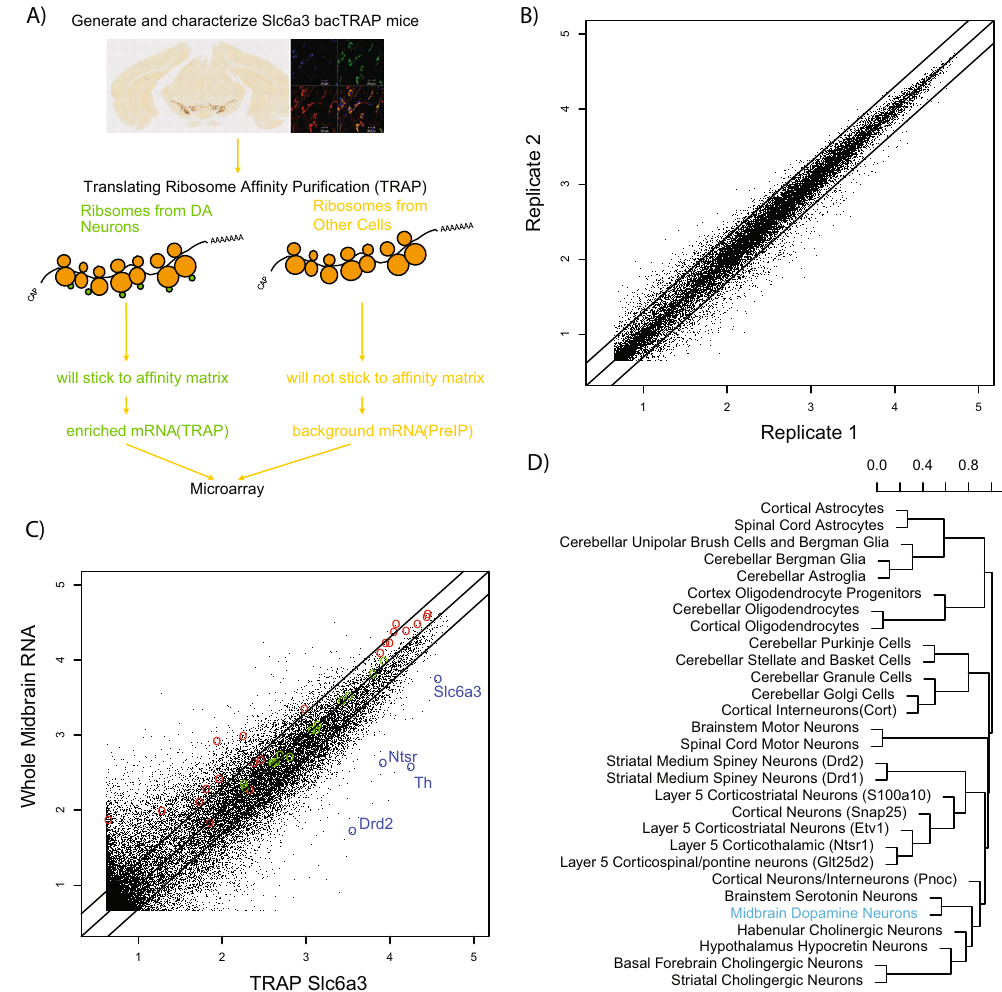
Figure 2. Slc6a3 JD1640 TRAP line allows for reproducible and specific purification or mRNAs from midbrain dopamine neurons. ( A ) Illustration of the bacTRAP method. Specific cell types are driven to express a GFP tagged ribosomal protein(RPL10A) using a cell type specific promoter in engineered from a bacterial artificial chromosome (BAC). After validation of the line, midbrains can be homogenized and lysates incubated with anti-GFP coated magnetic beads to enrich for mRNA from DA neurons. ( B ) Two microarray experiments on independent pools of Slc6a3 JD1640 TRAP mice result in reproducible mRNA expression (Pearson r > 0.98). ( C ) Comparison of TRAP purified from mRNA from Slc6a3 JD1640 TRAP to total RNA of midbrain shows robust enrichment of transcripts known to be expressed in dopaminergic neurons (blue), and moderate depletion of known glial genes (red). Lines in A and B show 2-fold enrichment or depletion (Pearson r > 0.90). ( D ) Hierarchical clustering of a variety of TRAP microarray datasets based on all transcripts with a pSI < 0.001 in any cell type reveals midbrain dopamine neurons(blue) are most similar to other neuromodulatory cells in enriched gene